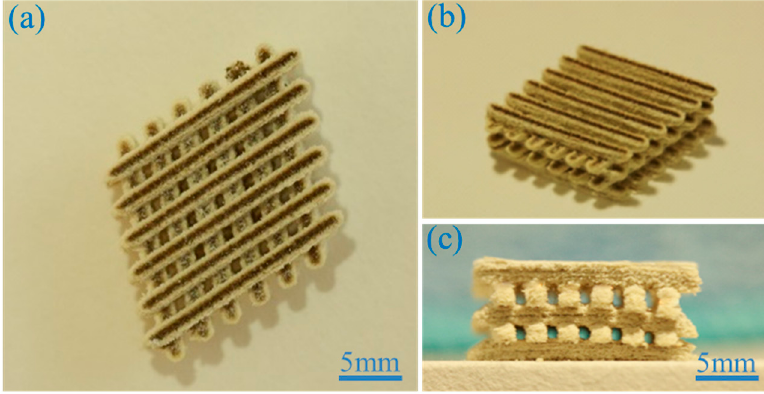
Figure 1. ( a ) Top view; ( b ) isometric view; and ( c ) lateral view of the polyetheretherketone/ polyglycolicacid-hydroxyapatite (PEEK/PGA-HAP) composite scaffold.